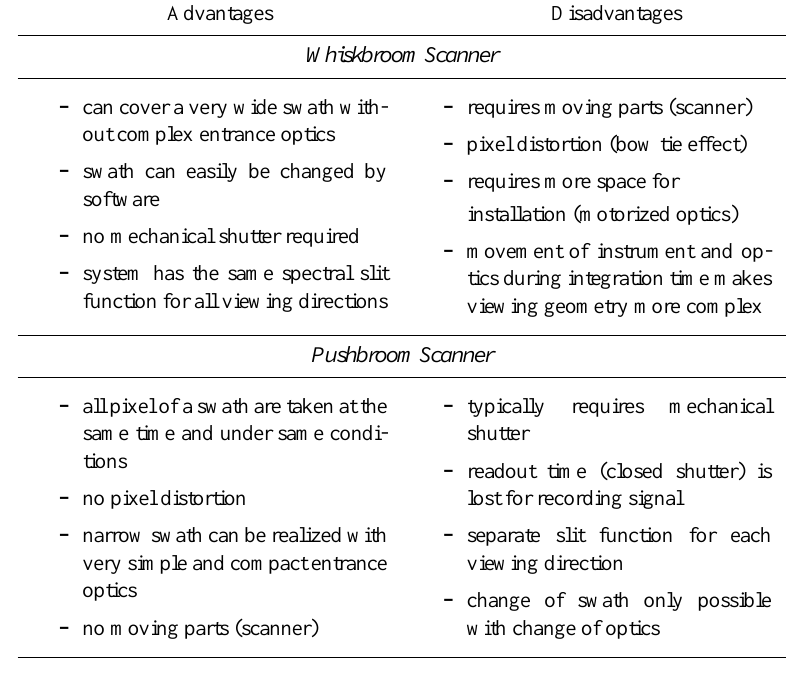
Table 2. Advantages and disadvantages of the different remote sensing techniques used by the HAIDI system. Advantages